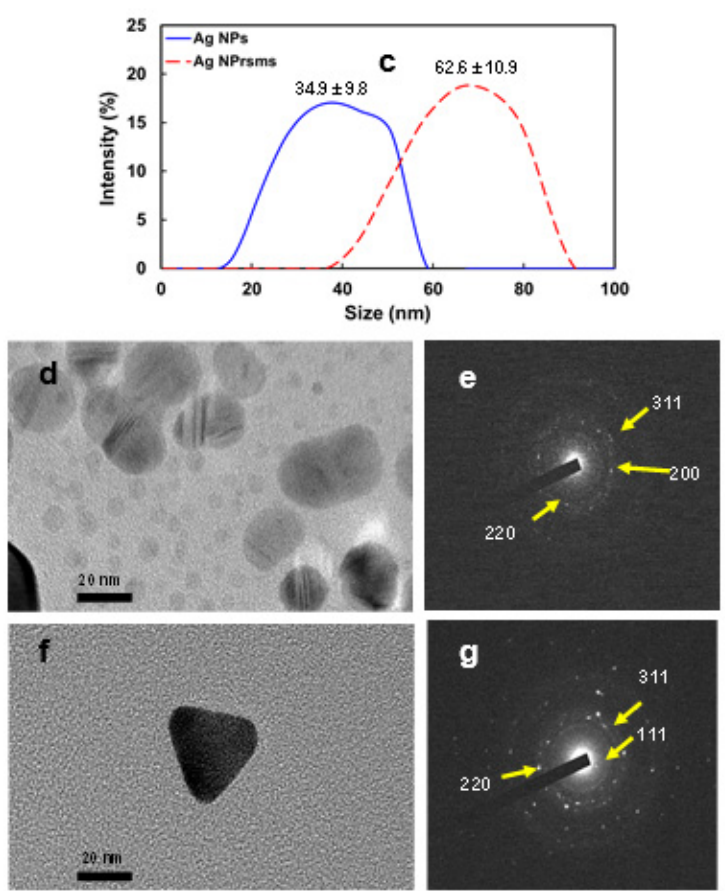
Figure 2. TEM images of Ag NPs ( a ) and Ag NPrsms ( b ); size distribution of Ag NPs and Ag NPrsms as measured using DLS ( c ); HRTEM of Ag NPs ( d ), SAED lattice pattern diffraction of Ag NPs ( e ), HRTEM of Ag NPrsms ( f ) and SAED lattice pattern diffraction of Ag NPrsms ( g ).